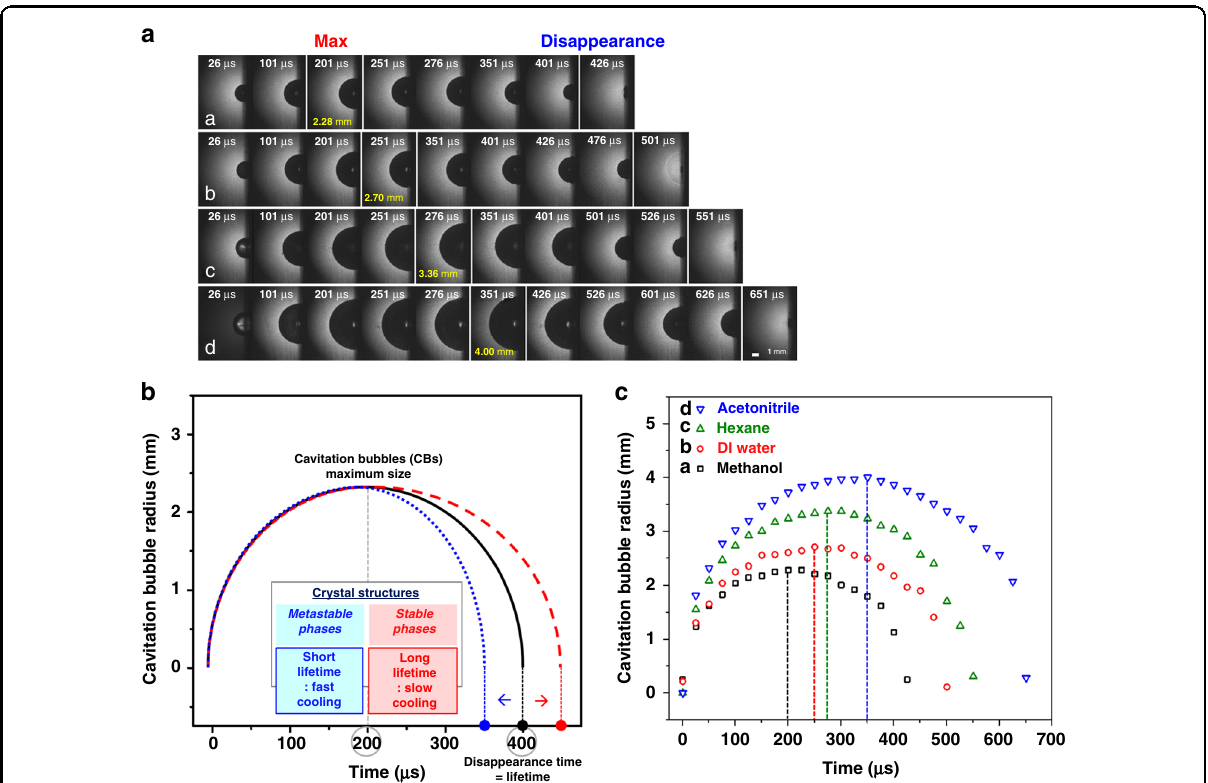
Fig. 7 Dynamics studies of LICBs. a Time-resolved images of LICBs taken during the PLA of the Ni plate for 30 min in (a) methanol, (b) DI water, (c) hexane, and (d) ACN medium; b theoretical lifetime values of LICBs obtained based on the Rayleigh – Plesset theory; c time-resolved LICB radius evolved during the PLA of the Ni plate in (a) methanol, (b) DI water, (c) hexane, and (d) ACN medium 25 . Copyright (2021) Elsevier